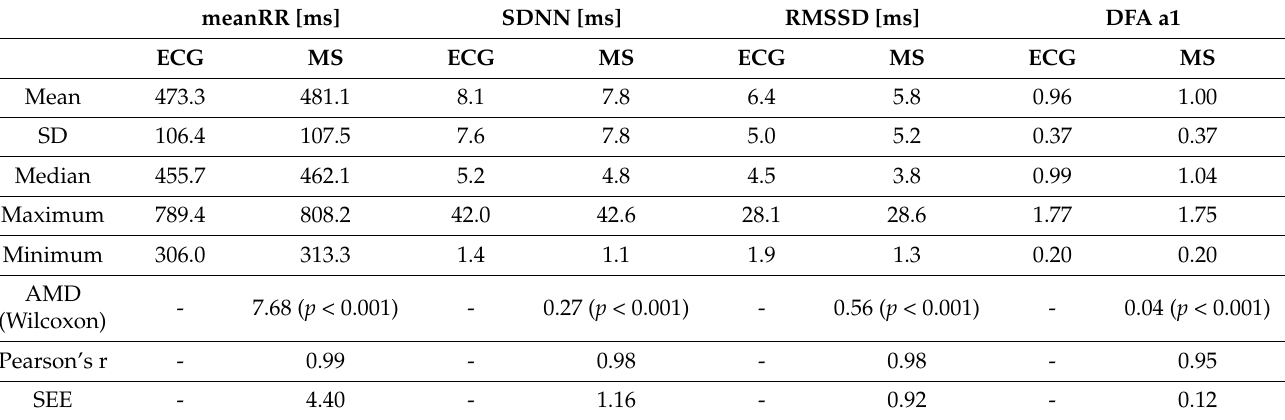
Figure 5. Regression plots for the comparison of the 12 channel ECG (ECG) and the Movesense Medical sensor (MS) during the incremental exercise test for meanRR ( A ), SDNN ( B ), RMSSD ( C ), and DFA a1 ( D ). Slope, coefficient of determination (R 2 ), standard error of estimate (SEE), and p value are shown in the bottom right of each plot. Table 2. Mean, standard deviation (SD), Median, Minimum, Maximum, adjusted median difference (AMD) for the comparison of the 12 channel ECG (ECG) and the Movesense Medical sensor (MS) according to Hodges Lehmann method ( p -value estimated by Wilcoxon paired testing), Pearson’s r and Standard Estimate of Error (SEE) from paired data for meanRR, SDNN, RMSSD, and DFA a1 during the incremental